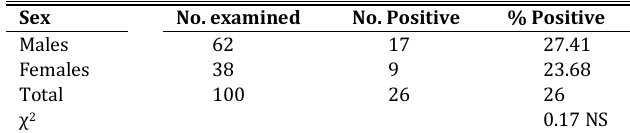
Table 2. Prevalence of Cryptosporidium spp. according to human